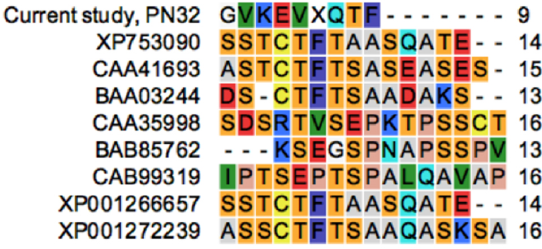
Figure 3. Comparison of the N-terminal amino acid sequence of existing polygalacturonase and PN32.